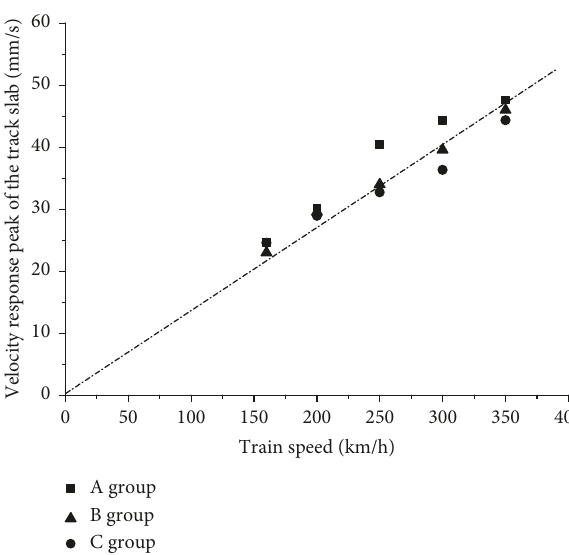
Figure 7: Vertical velocity with respect to train